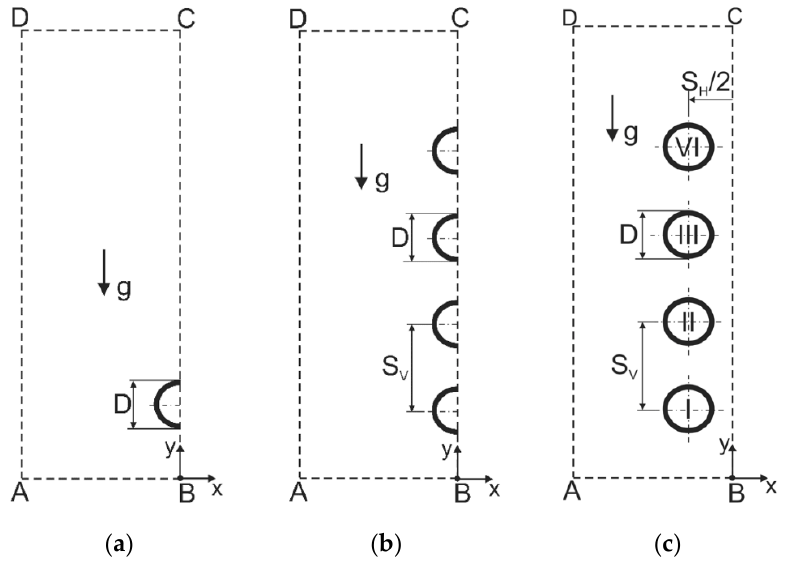
Figure 1. Arrangement of the single cylinder and tube arrays 4 × 1 and 4 × 2: ( a ) single cylinder; ( b ) 4 × 1 tube array; ( c ) 4 × 2 tube array.